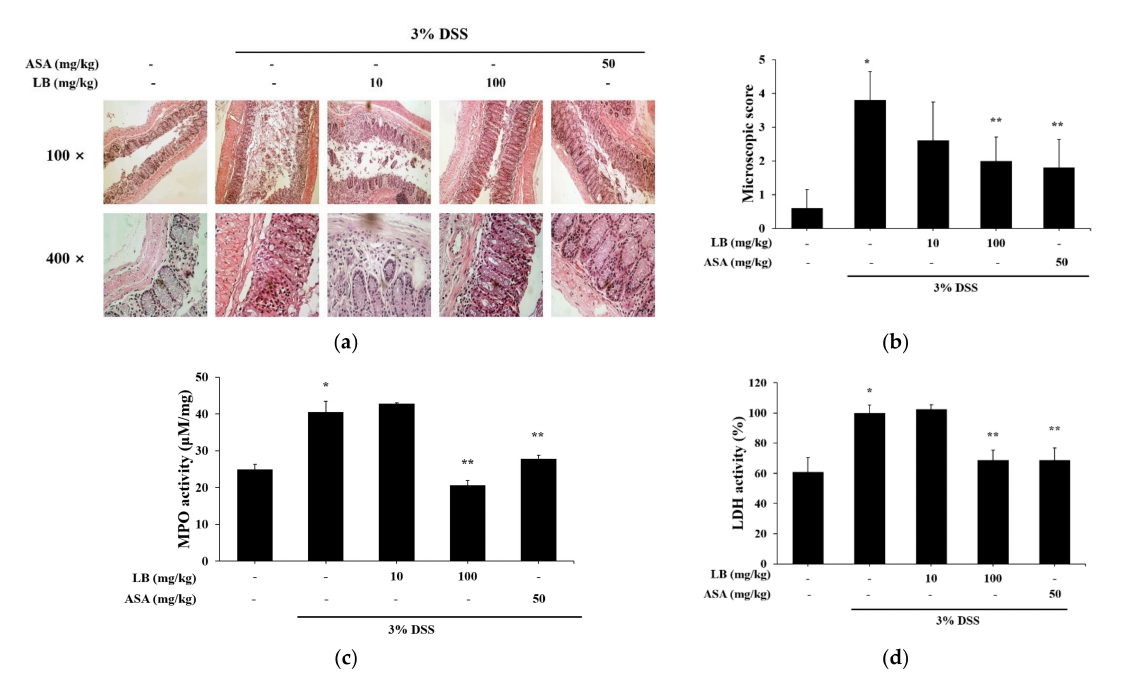
Figure 2. LB regulates histological injury and MPO activity. To induce UC, 3% DSS was administered, and LB and 5-ASA were given to treat the histological injury. ( a ) Paraffin sections of colonic tissues were stained with H&E and observed through a microscope (scale bar = 100 × and 400 × ); ( b ) microscopic score; ( c ) MPO activity; ( d ) LDH activity. Values are represented as the mean ± S.D. The data were analyzed by Bonferroni’s post-hoc test. * p < 0.05 versus Blank group and ** p < 0.05 versus DSS